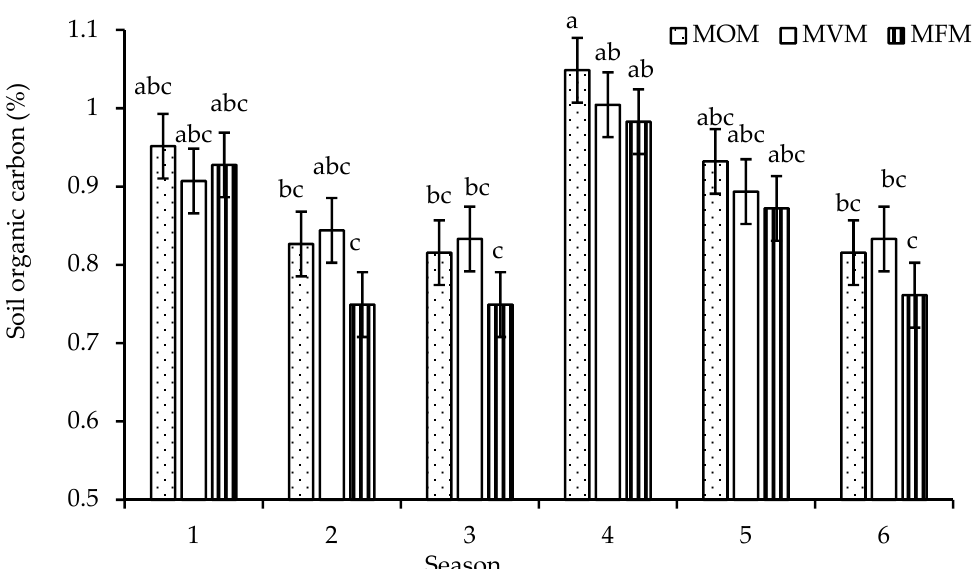
Figure 4. Interactive effects of season and crop rotation on soil organic carbon at the 5–10 cm depth in a maize-based conservation agriculture system in a semiarid climate in South Africa. Different lowercase letters indicate significant differences at p < 0.001.